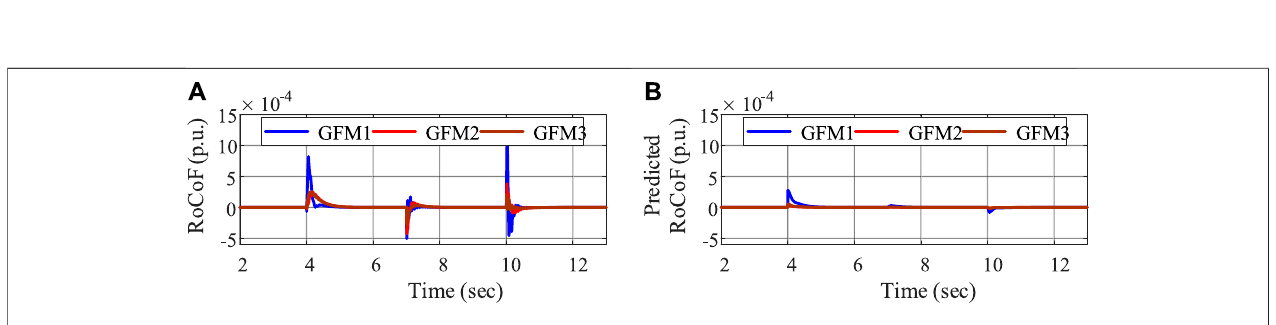
FIGURE 8 | Analysis of the RoCoF prediction model: (A) RoCoF and (B) one-step RoCoF prediction.